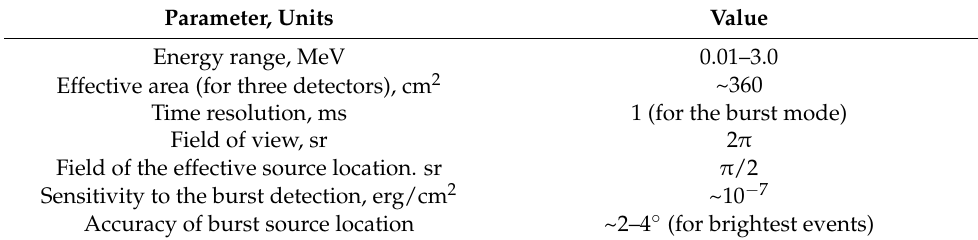
Sensitivity to the burst detection, erg/cm 2